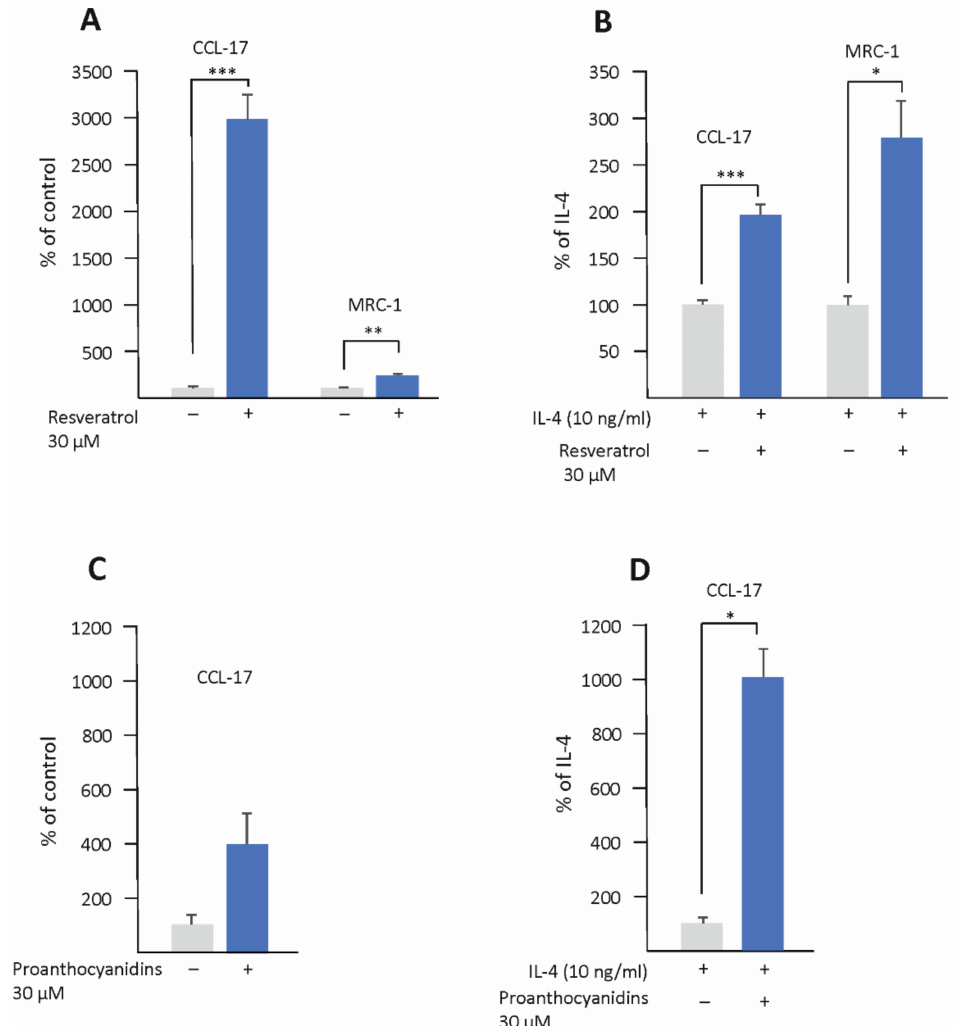
Figure 6. ResveratrolandproanthocyanidinsenhancedtheexpressionofCCchemokineligand17(CCL-17) and resveratrol also that of mannose receptor C-type 1 (MRC-1) in human U937 macrophages. Cells were cultured with resveratrol or proanthocyanidins alone ( A , C ) or with IL-4 ( B , D ) for 24 h. The expressions of CCL-17 and MRC-1 were measured by RT-PCR and normalized against GAPDH. CCL-17/MRC-1 expression in untreated ( A , C ) or IL-4-treated ( B , D ) cells was set as 100% (marked as gray bar), and the other values (resveratrol or proanthocyanidins, marked as blue bars) are presented in proportion to that value. Results are given as the mean + SEM, n = 3–4. Statistical significance of the results was calculated by the t -test. Mean values significantly different from the control are marked with * p < 0.05, ** p < 0.01, and *** p <